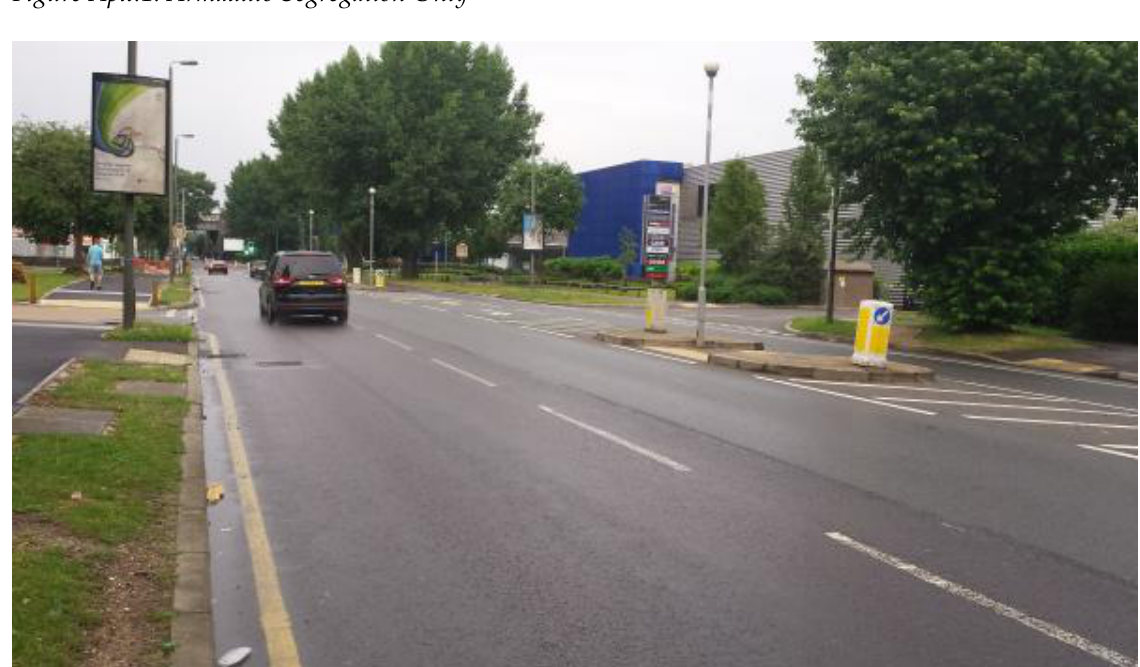
Figure Apx.1. Armadillo Segregation Only